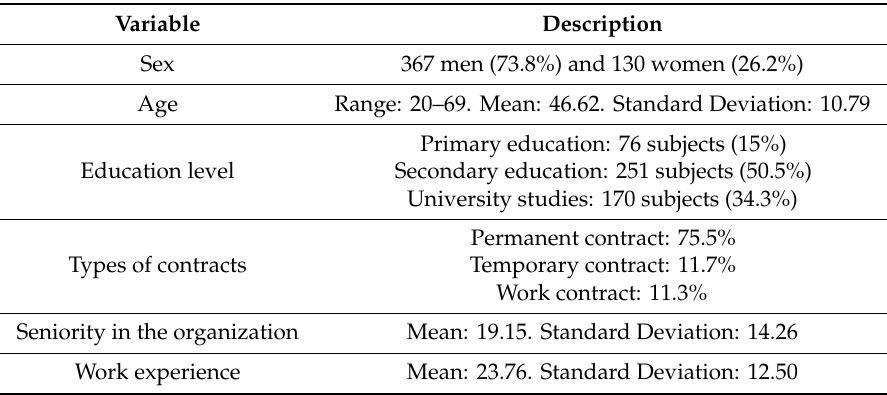
Table 1. Description of the